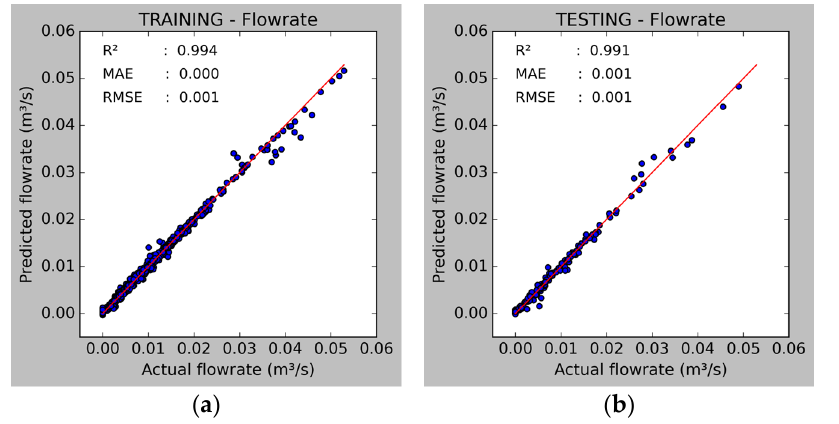
Figure 8. Scatterplot of the flowrate prediction model using ( a ) training data and ( b ) testing data. Table 6. Performance evaluation of flowrate and static pressure models. Figure 10 shows the P-Q Curve using the optimum design parameter. The red dot indicates the operating point and the blue dots indicate the static pressure values using flowrate variation. In Figure 10, the red point is on the P-Q Curve, meaning that the specified parameter conformed to the design range. P ratio and Q ratio are 0.5, which is within the design range. Therefore, the red dot point is almost in the center of the blue